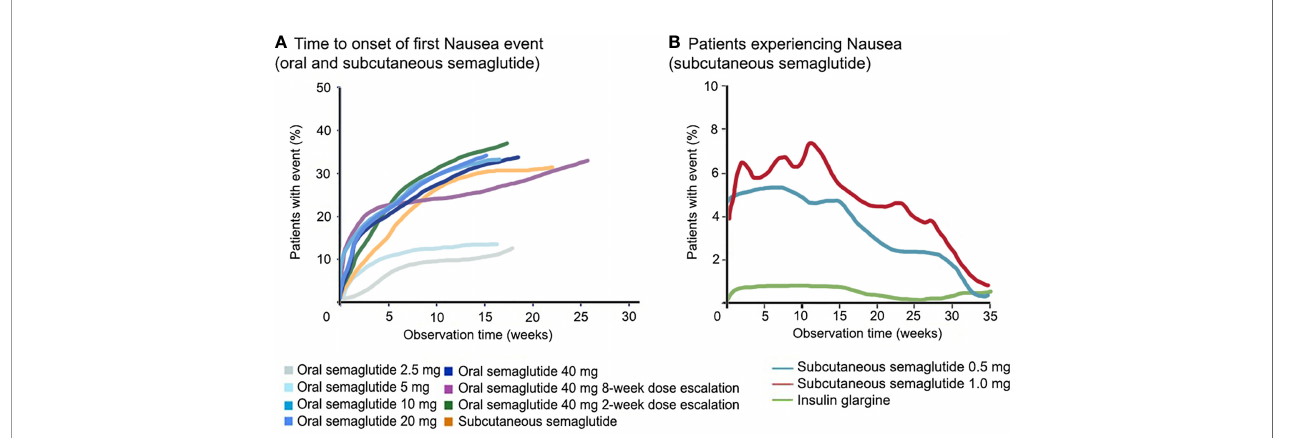
FIGURE 2 | Course of nausea with semaglutide. GLP-1RA, including semaglutide, cause nausea in about one third of treated patients, which is both dose- and time-dependent. In panel (A) , a direct comparison between subcutaneous and oral semaglutide is shown, as well as different doses of oral semaglutide, for the fi rst occurrence of nausea. In panel (B) , the course of the occurrence of nausea is shown for subcutaneous semaglutide. Data for panel (A) are derived from the phase-2 trial (38), for panel (B) data are shown from (26). GLP-1RA, glucagon-like peptide-1 receptor